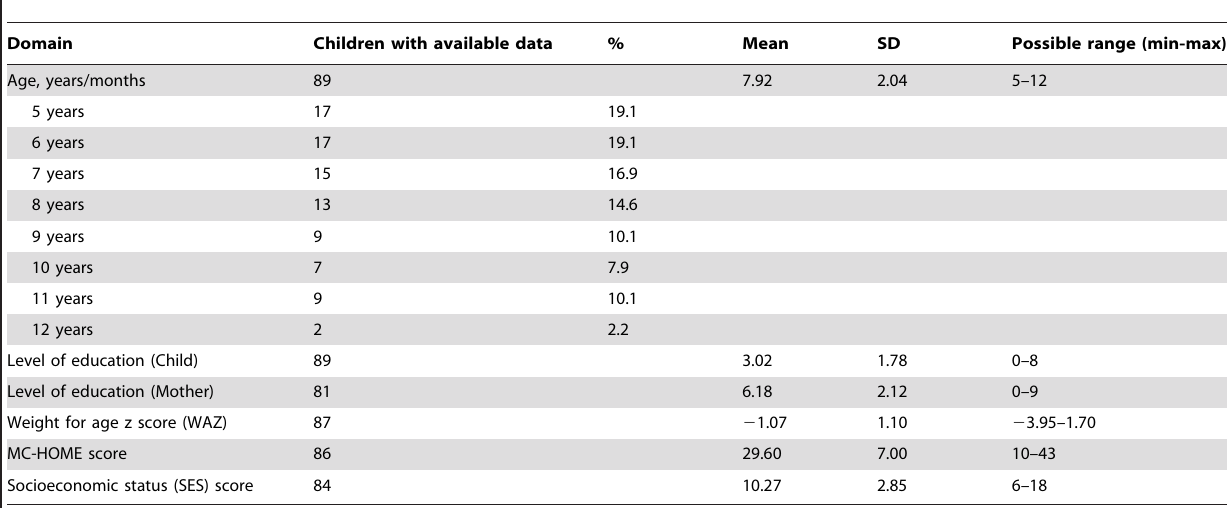
Table 1. Demographic characteristics of study participants at